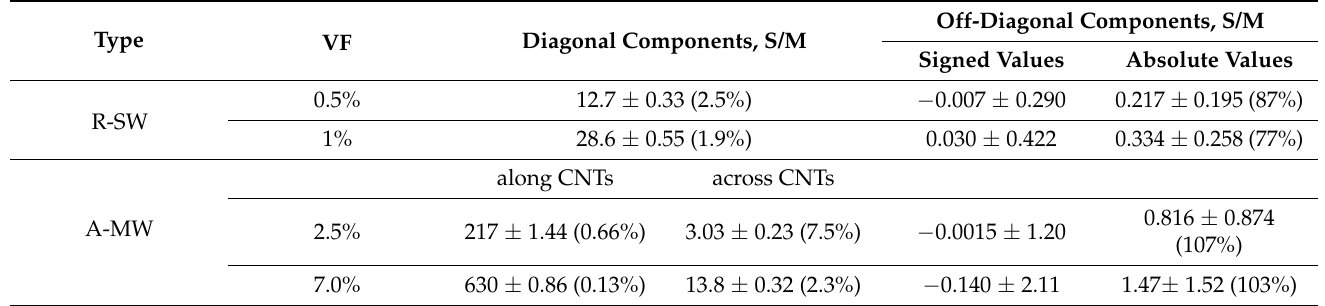
Table 3. Homogenized conductivity tensor components at the reference point of the numerical plan: g intr = 10 4 S/m, ∆ E 1 = 3 eV, and s min = 0.34 nm.